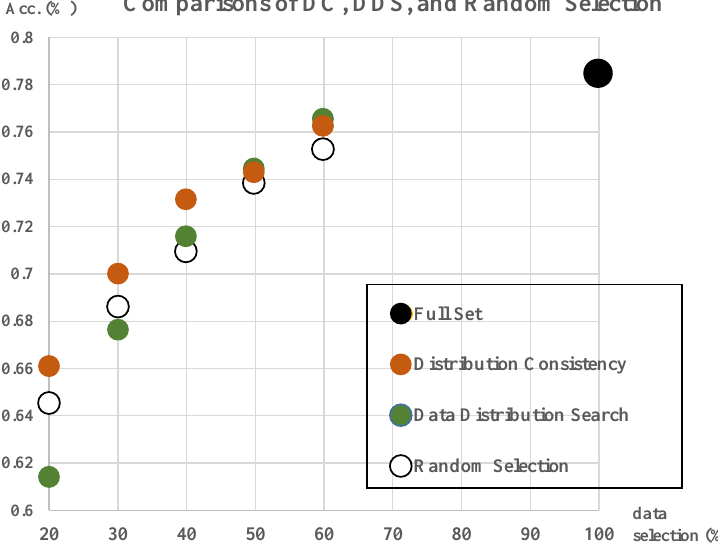
Figure 8. Accuracies of data subsets selected based on high DC ( r g = 0.005), DDS (the best case), and random selection.